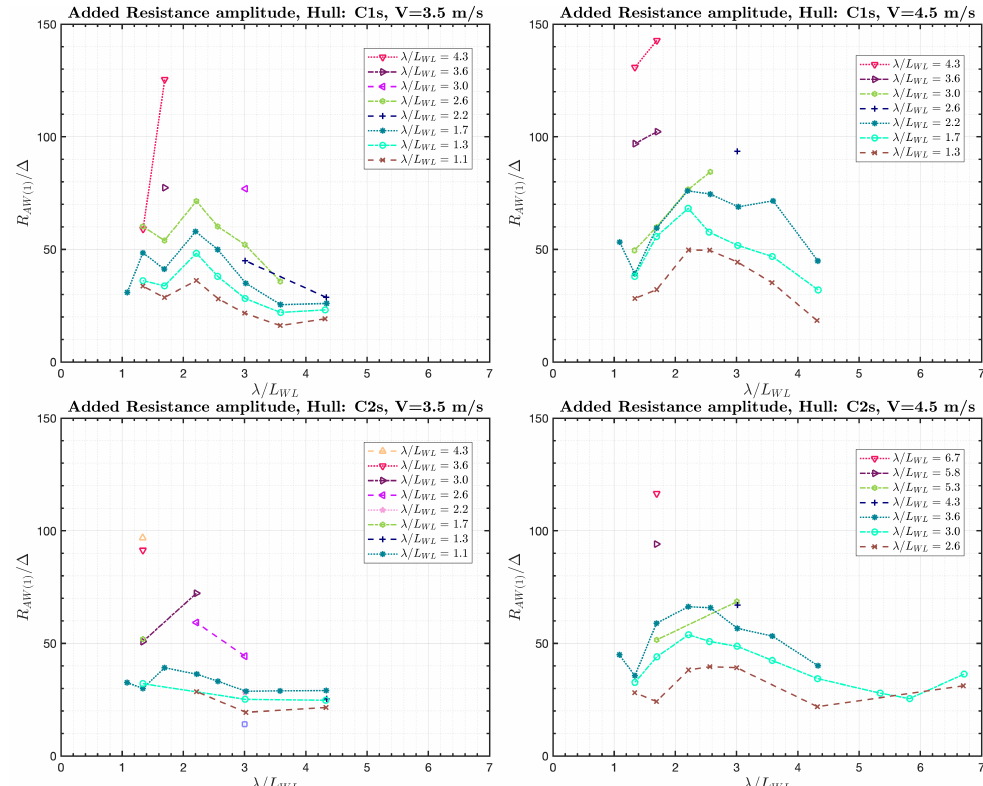
Figure 9. Added resistance first harmonic amplitude vs. λ / L WL